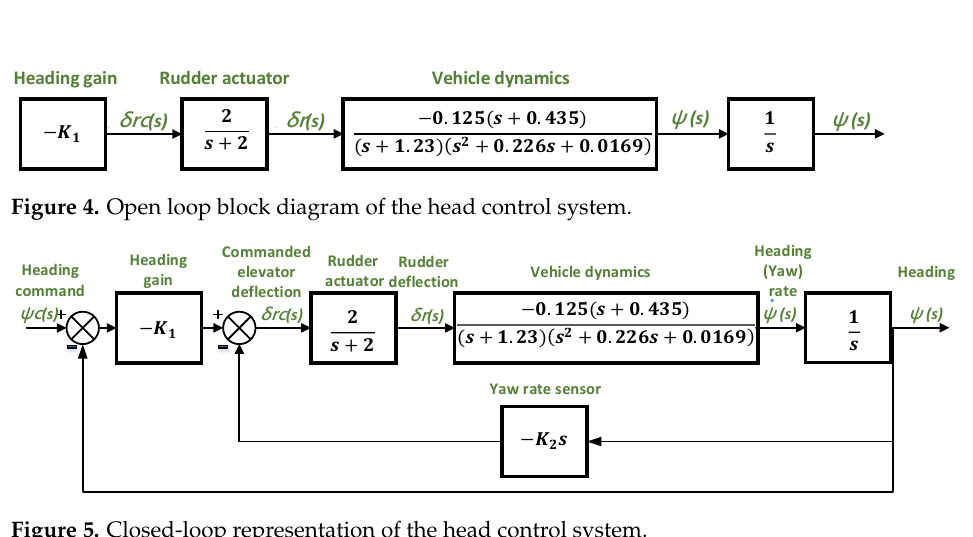
Figure 5. Closed-loop representation of the head control